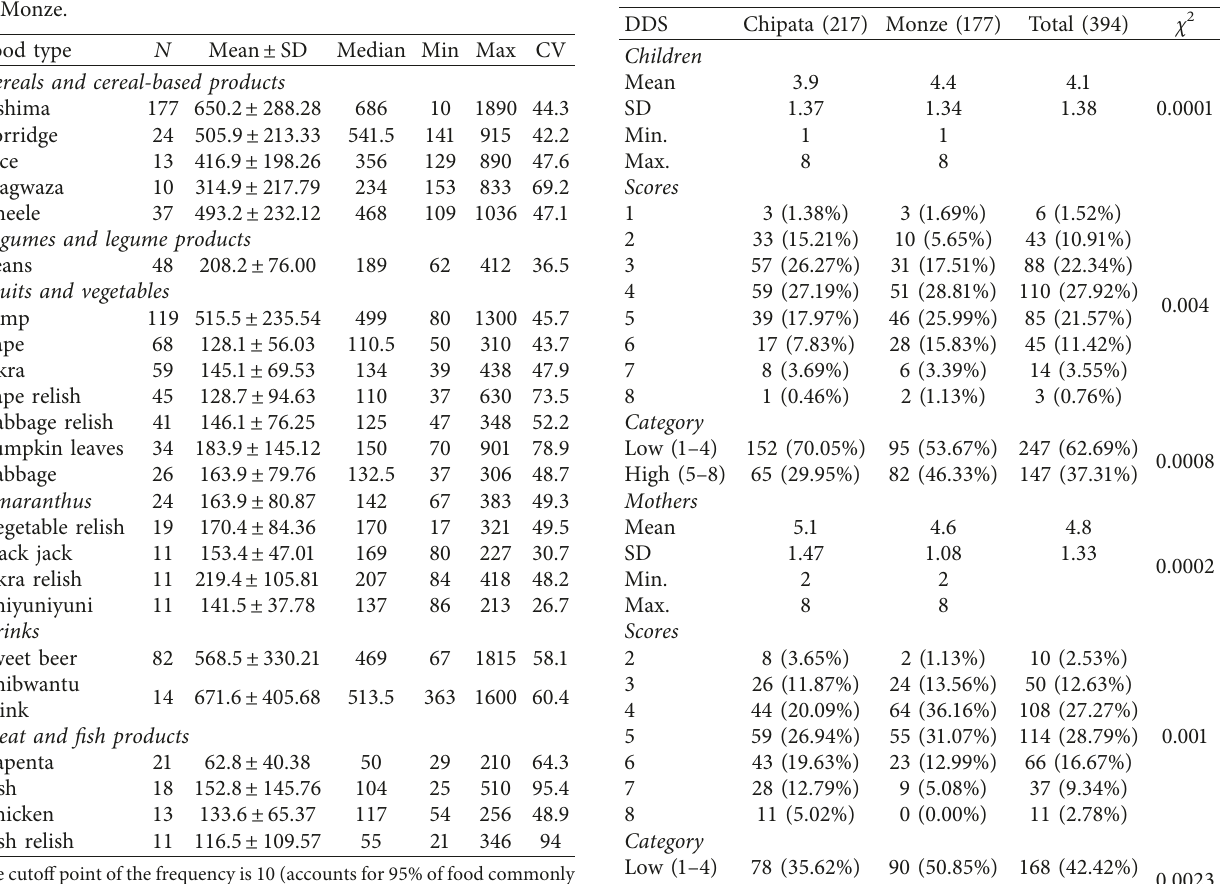
Table 7: Dietary diversity scores (DDSs) for children and mothers. Table 6: Food frequency and weight (grams) consumed by mothers